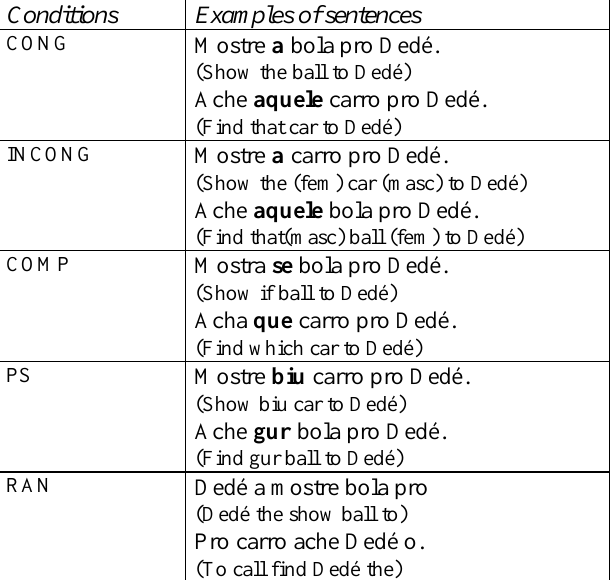
Table 2. Examples of test-sentences in the experimental and in the control